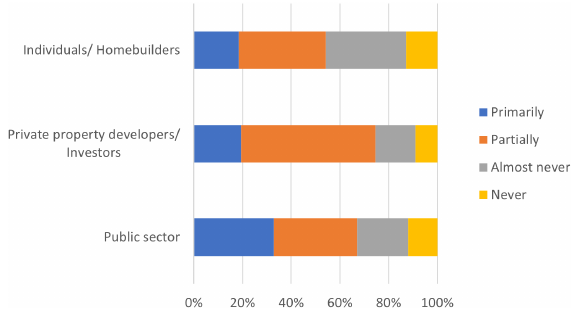
Figure 8. Responses to the question: How would you describe your organisation’s (future) use of LCA? (based on 54